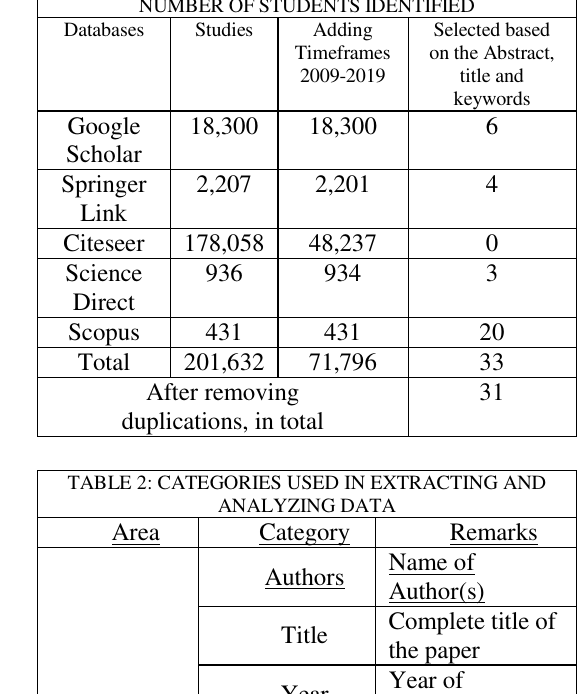
TABLE 1: SUMMARY OF DATABSES AND NUMBER OF STUDENTS IDENTIFIED